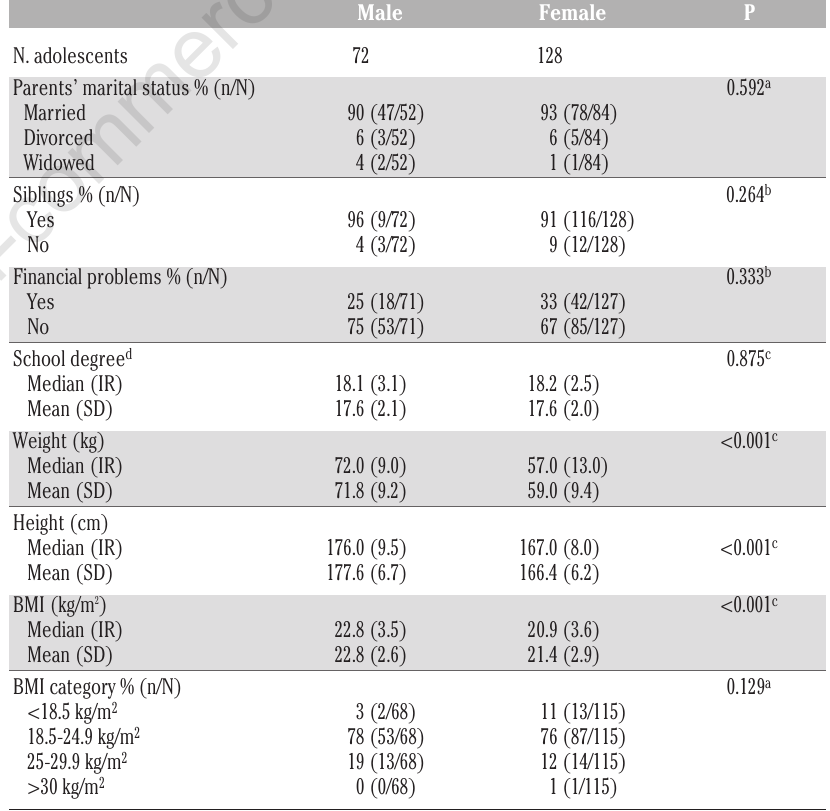
Table 1. Sociodemographic and separate somatometric characteristics of Greek adoles- cents according to